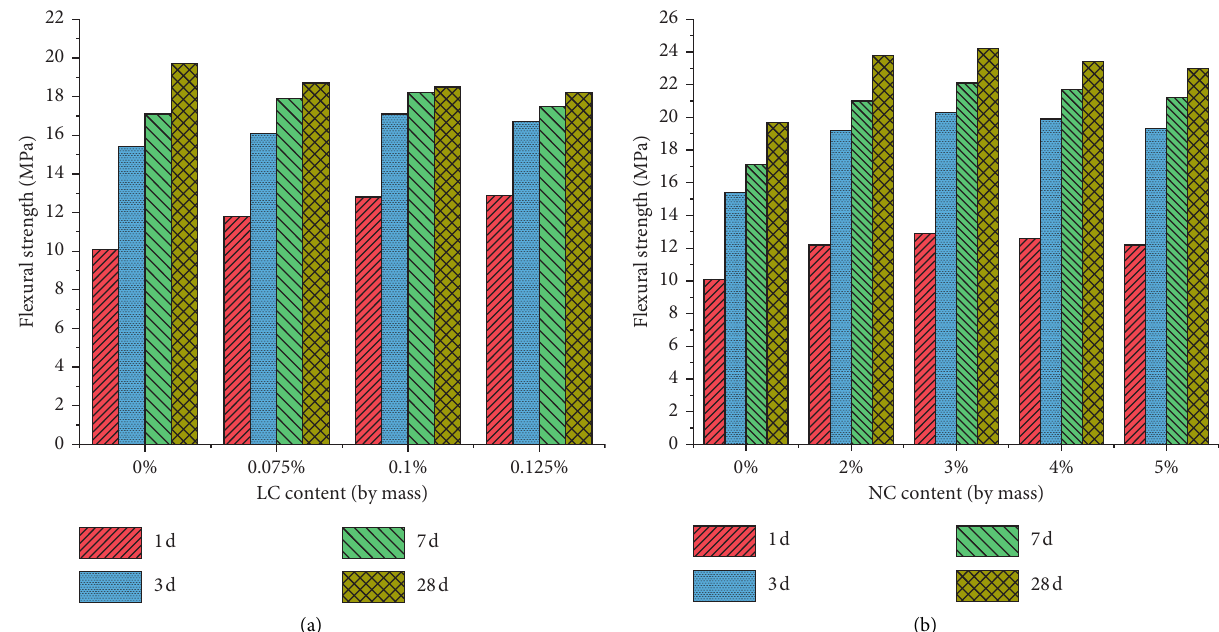
Figure 3: Effects of LC and NC single-type dosage on the UHPC flexural